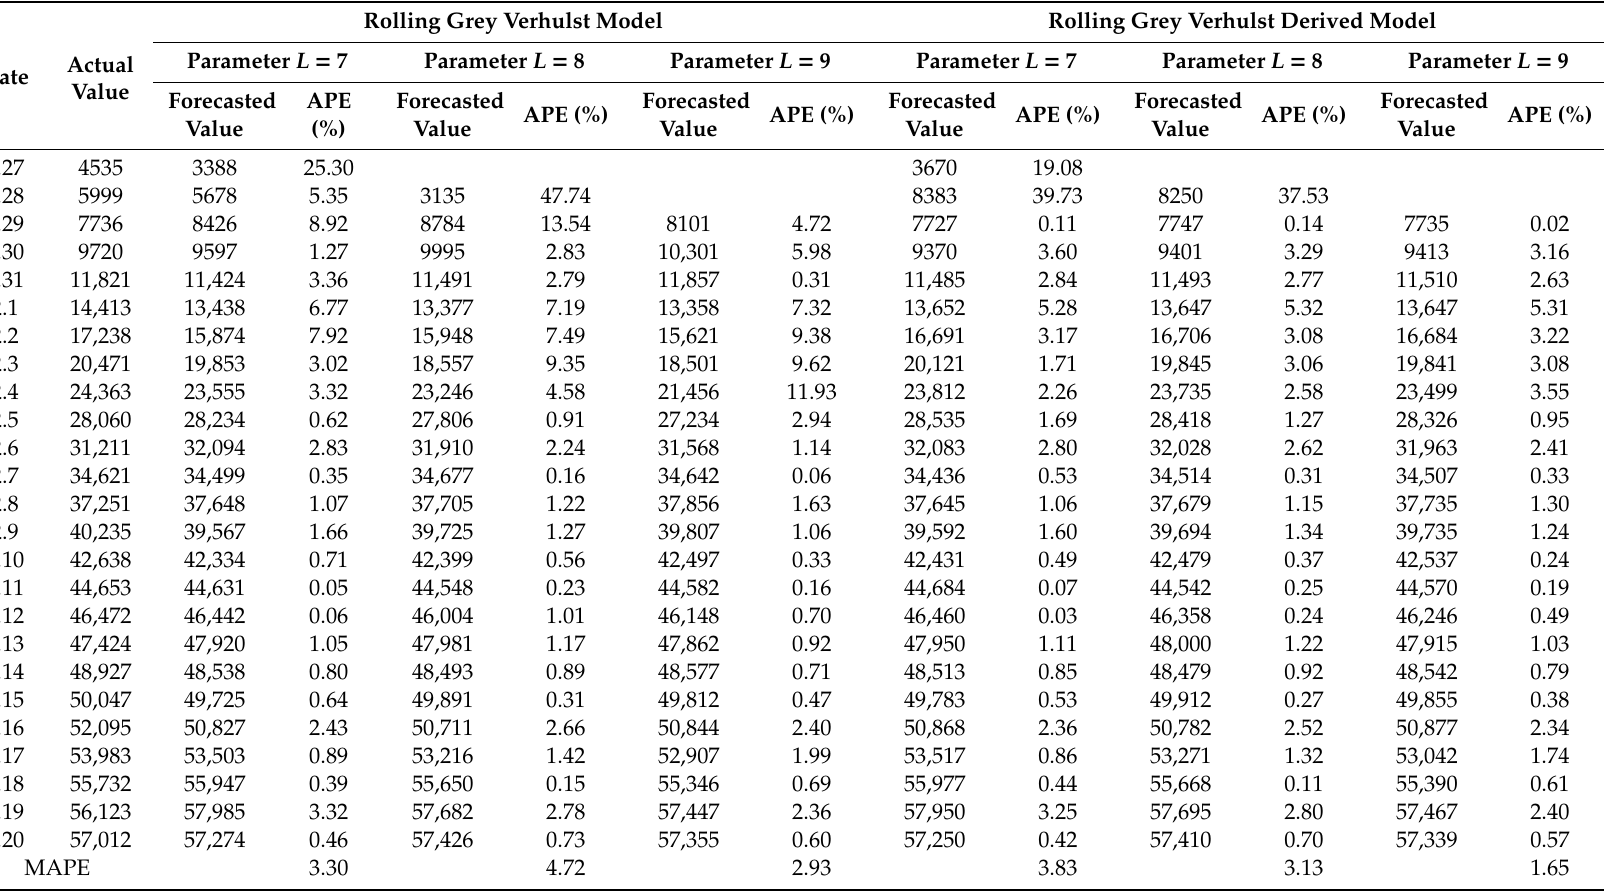
Table 4. Predicted values and MAPE values of the testing